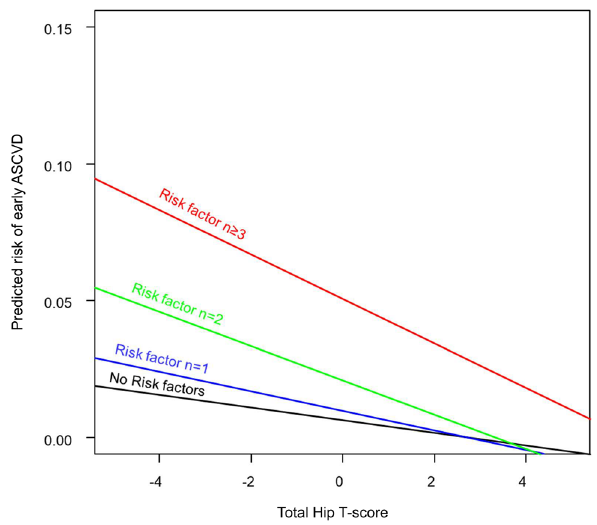
Figure 4. Predicted risk of early ASCVD according to BMD T-score and the number of clinical risk factors. The predicted risk of early ASCVD across the range of BMD T-scores, stratified by the number of co-existing risk factors, is shown. An inverse trend between the predicted risk and BMD T-score was consistently observed, regardless of the number of risk factors. Of note, the strength of the trend increased with a greater number of the risk factors. ASCVD atherosclerotic cardiovascular disease, BMD bone mineral